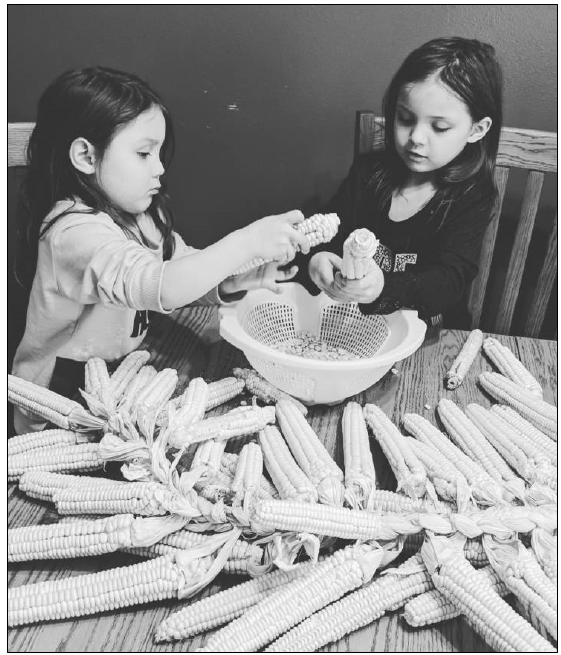
Photo courtesy of Stephanie